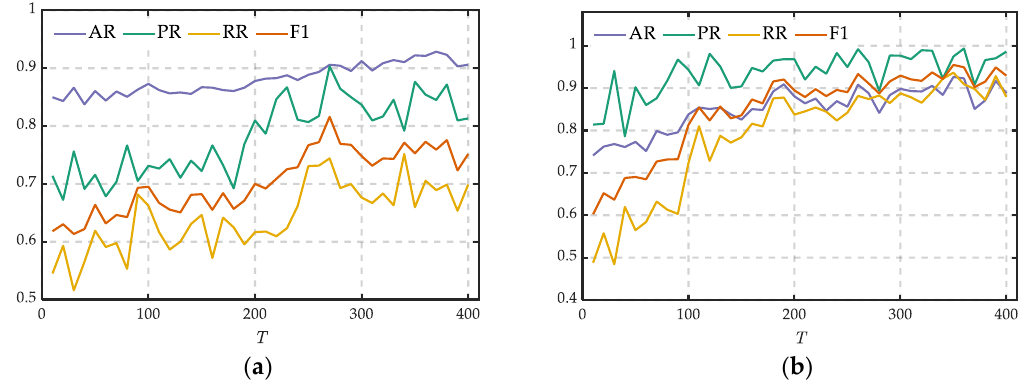
Figure 8. Performances of different T . ( a ) Trends of indicators in dataset (a); ( b ) trends of indicators in dataset (b).